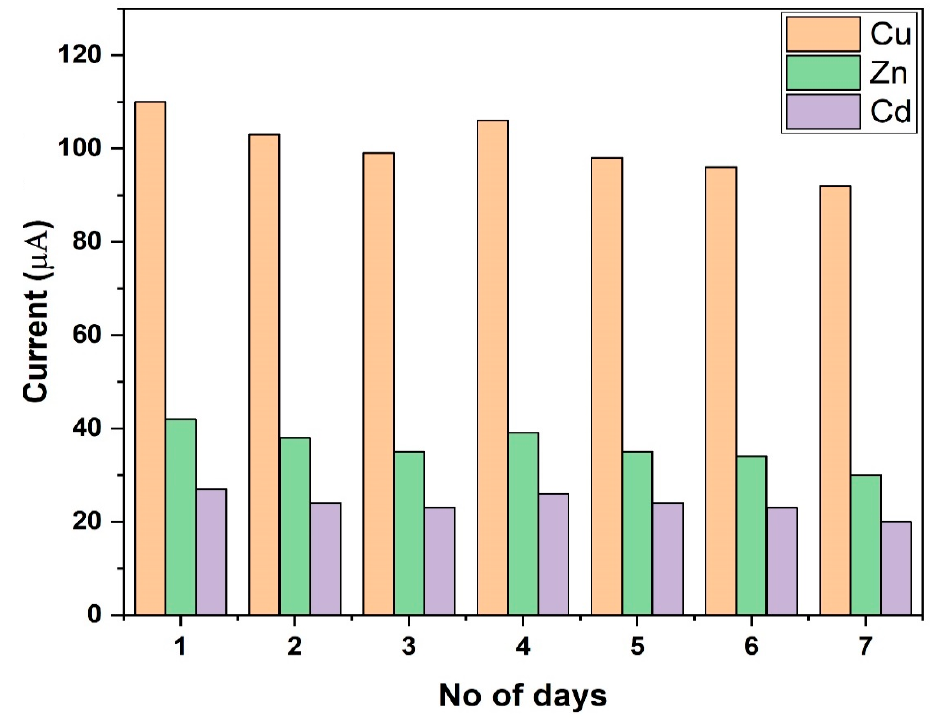
Figure 10. Long term stability of MnO 2